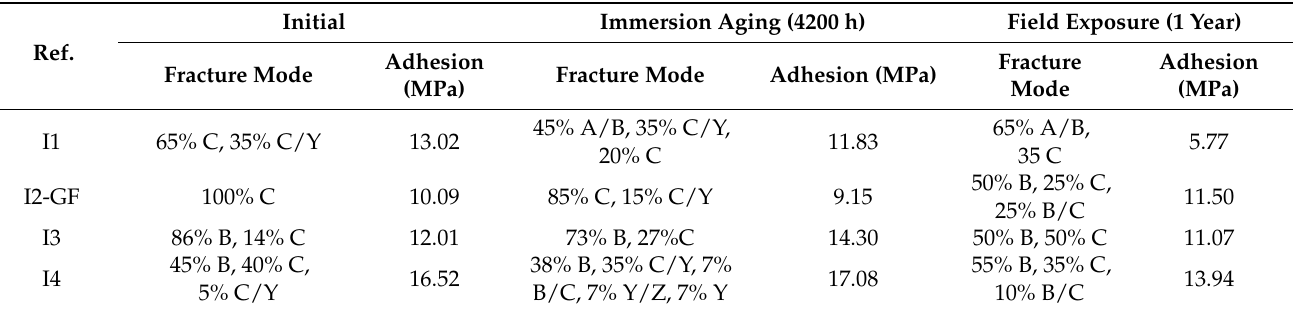
Table 10. Adhesion strength (average) of the coating systems for the submerged zone before and after aging and field